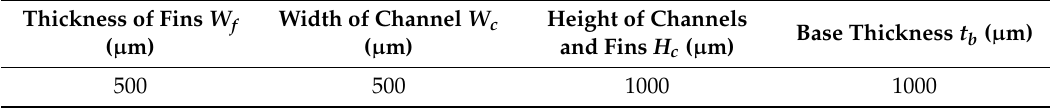
Figure 4. ( a ) Schematic of the three stacked layers microchannel: width of channels ( W c ), height of fins ( H c ), thickness of fins ( W f ), length of plate ( L ), width of plate ( W ), base thickness ( t b ); ( b ) microscopic images of the side of the plate; ( c ) surface finish under the microscope. Table 2. The dimensions of the microchannel.